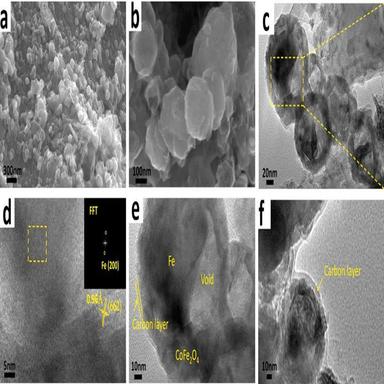
(a, b) SEM images of Fe@CoFe2O4@C, (c, e and f) TEM images of Fe@CoFe2O4@C, (d) HR-TEM image of Fe@CoFe2O4@C, the inset image shows the FFT image of the selected area.